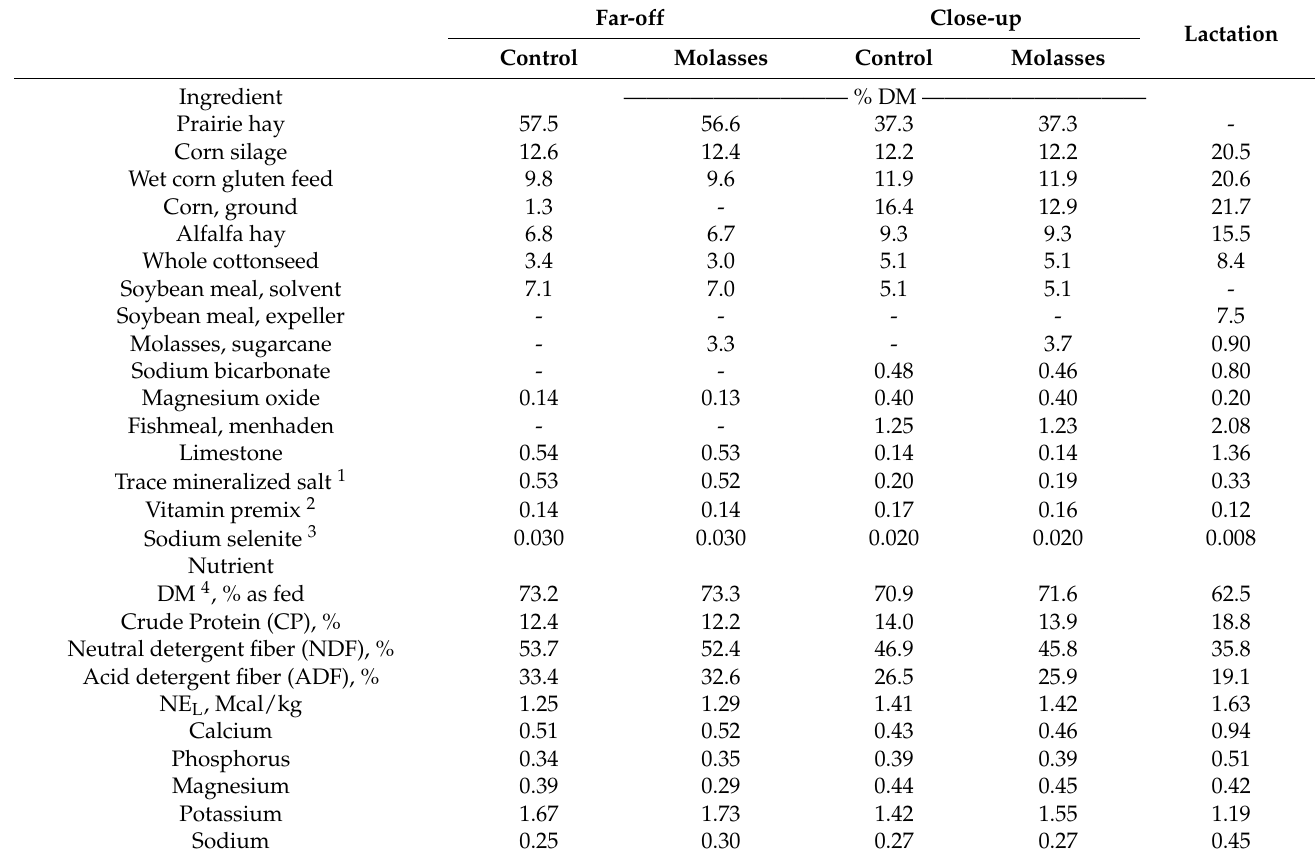
Table 3. Ingredient and nutrient composition of control and cane molasses-containing diets offered during a 60 day dry period for Experiment